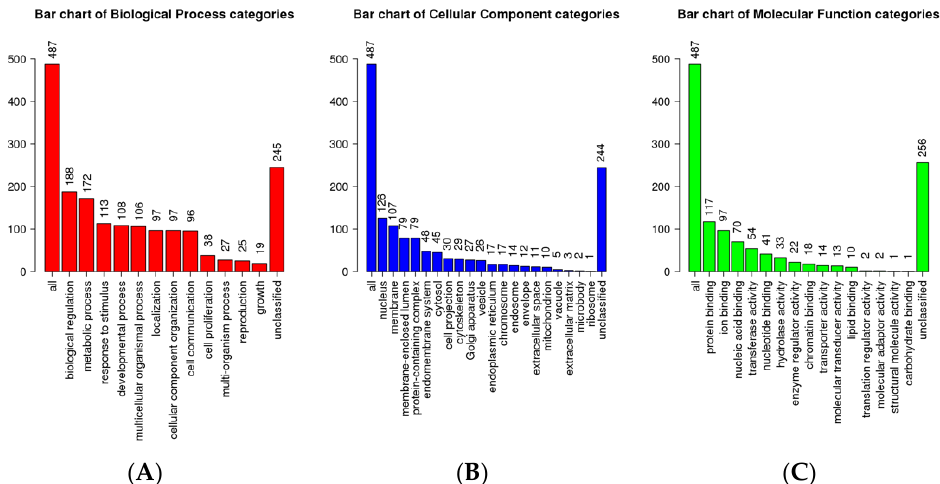
Figure 4. GO analysis of DE miR target genes. ( A ) Biological processes for differential miRNAs. ( B ) cellular components for differential miRNAs. ( C ) Molecular functions for differential miRNAs.